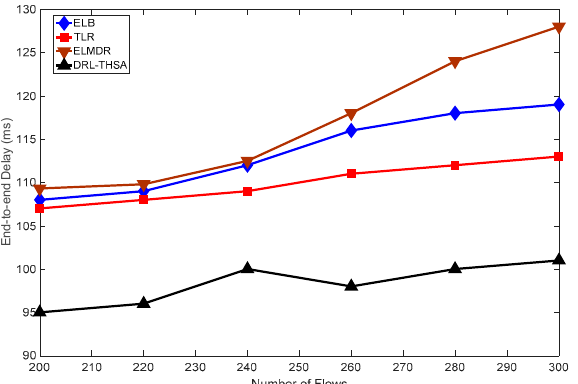
Figure 5. The average end ‐ to ‐ end delay with different number of flows.